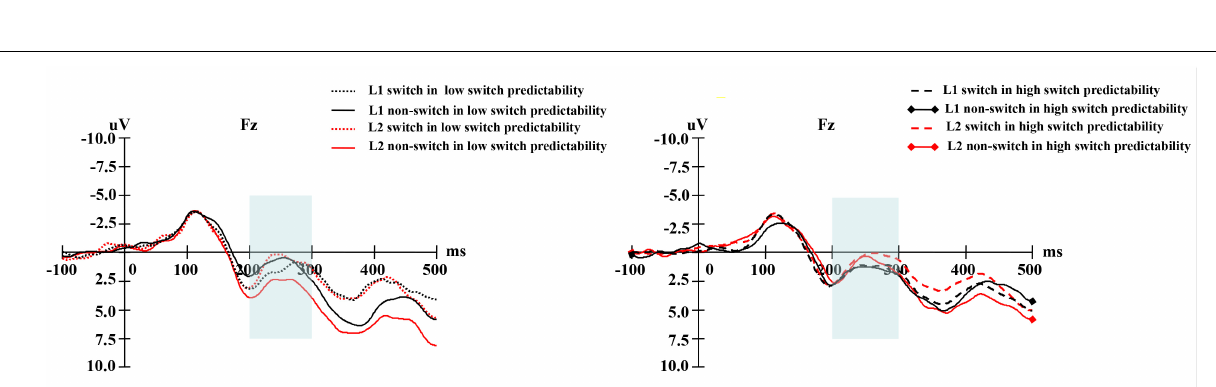
FIGURE 4 | (Left) Shows the averaged the early phase and (right) the averaged the late phase elicited by cues.